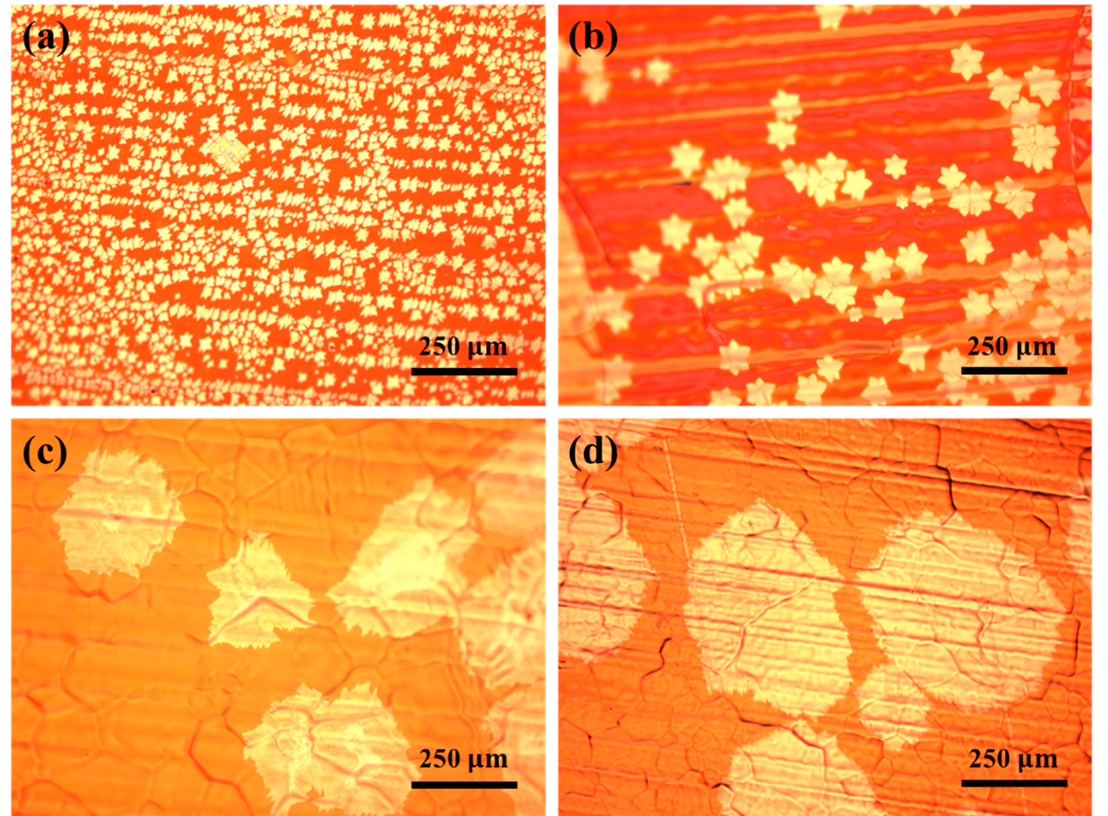
Figure 1. Optical micrographs of single-crystal graphene grown at different growth pressures under 200-times magnification observation: ( a ) 3, ( b ) 150, ( c ) 300, and ( d ) 450 Pa.